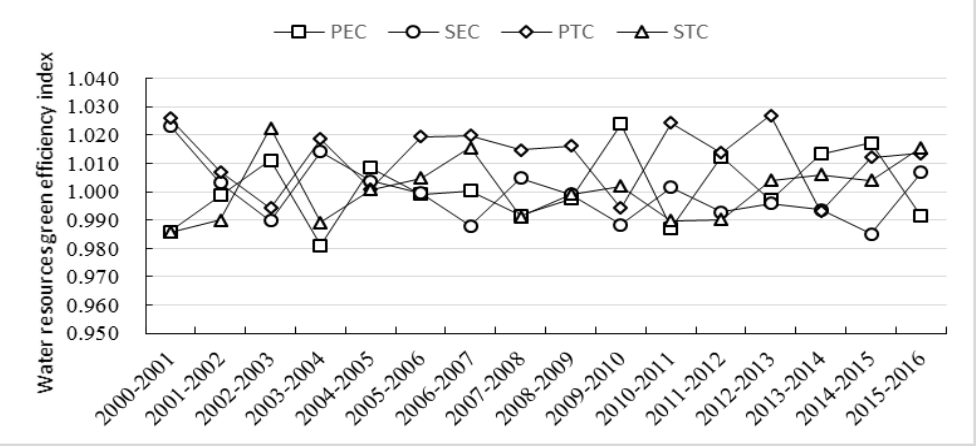
Figure 3. Changes in components of water resources green efficiency in China during the study period 2000–2016 (PEC = pure technical efficiency change, SEC = scale efficiency change, PTC = pure technology change and STC = scale technology change).